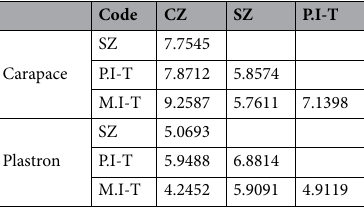
Table 6. Mahalanobis distances of carapace and plastron shape variation among T. graeca populations in Central Iran. Population codes are given in Fig. 5.